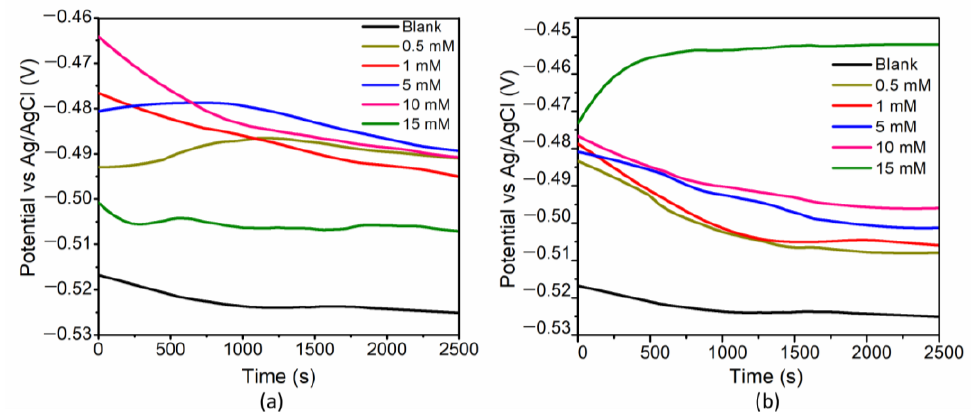
Figure 2. OCP at varying concentrations of ( a ) Py8 and ( b ) Py12 in 3.5% NaCl at pH 1.5 versus Ag/AgCl.